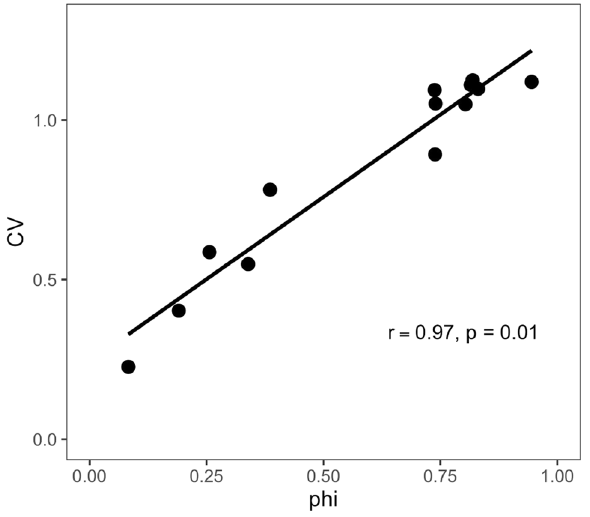
Figure 4. The relationship between community variability (CV) and synchrony (phi) for the reef-wide coral community over 13 years from 2006 to 2019. Line is fitted by model II major axis regression of CV on